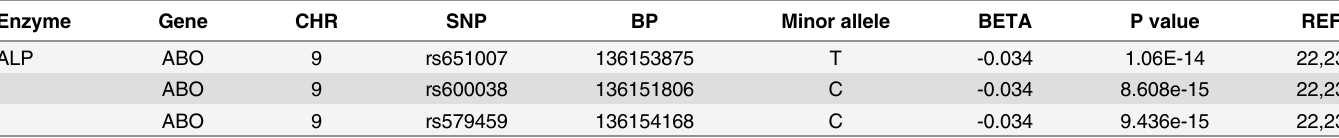
Except for serum total alkaline phosphatase, no other liver enzymes produced a genome wide significant effect (P < 1x10 -8 ). The effect of the ABO blood group locus and total alkaline phos- phatase that has been replicated in different studies was confirmed in our study (best p (cid:3) 1x10 - 15 for SNP rs600038, Table 4, Fig 4A). The effect was consistent across pediatric and adult cohorts. ABO blood type is known to be correlated with serum alkaline phosphatase, therefore we next identified perfect surrogate SNPs tagging ABO alleles in our dataset which include: rs8176704 for the A allele, rs505922 (or rs612169) for the O allele and rs8176746 (or rs8176672) for the B allele [35,36]. As shown in Fig 4B, after controlling for all three ABO SNP determinants, the association signal dramatically reduced for the lead SNP rs600038 with p- conditional = 0.02, consistent with previous studies. Of note, the linkage disequilibrium between lead SNP rs600038 and three ABO SNP determinants (rs505922 and rs8176746, rs8176704) were r2 = 0.39, 0.03 and 0.01 respectively.